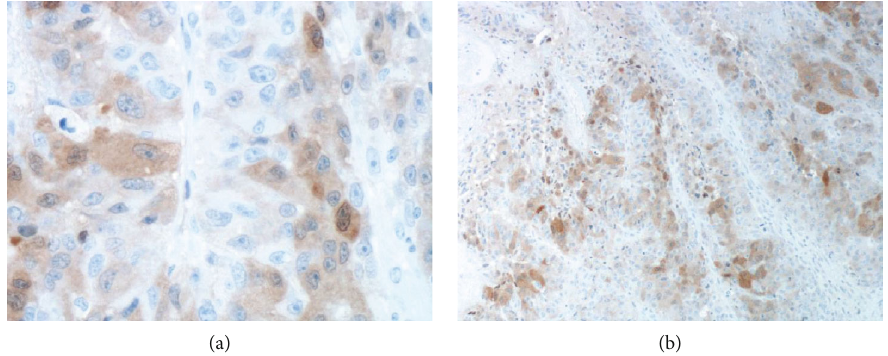
Figure 4: (a – b) Biopsy results showing the presence of HCC (high-power arginase